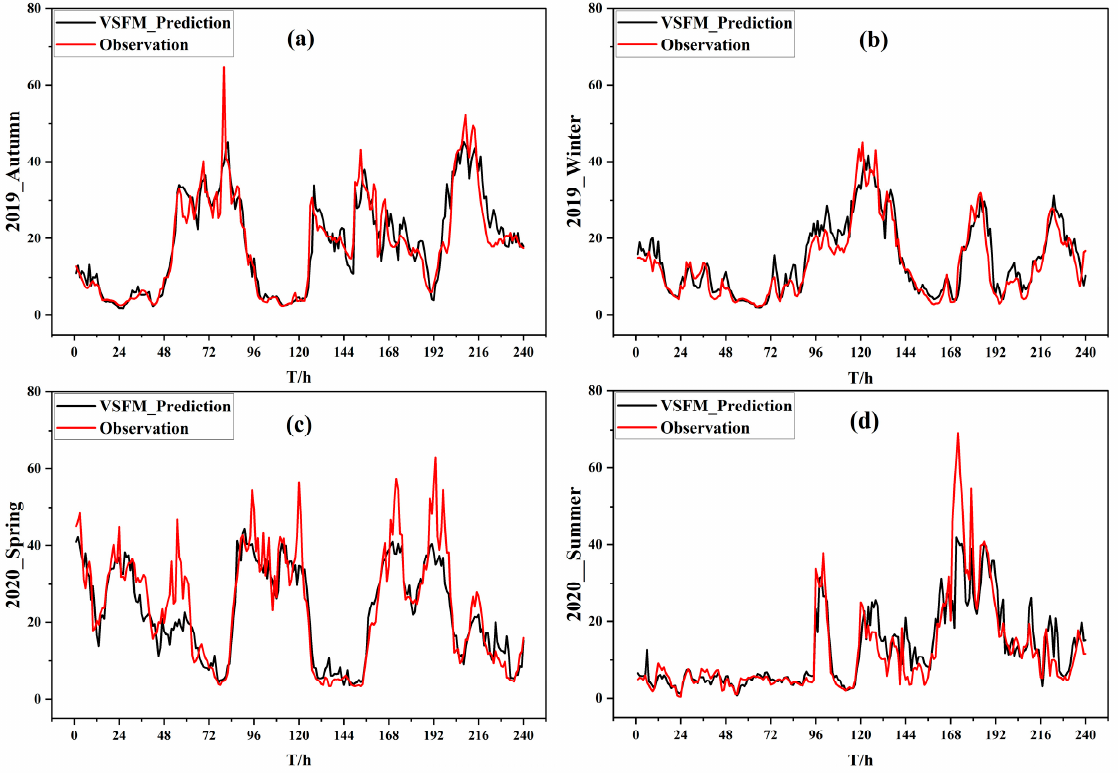
Figure 7. The prediction effect of the VSFM model in each season. ( a – d ) show the predicted values of the VSFM model versus the observed values for 2019_Autumn, 2019_Winter, 2020_Spring, and 2020_Summer, respectively.